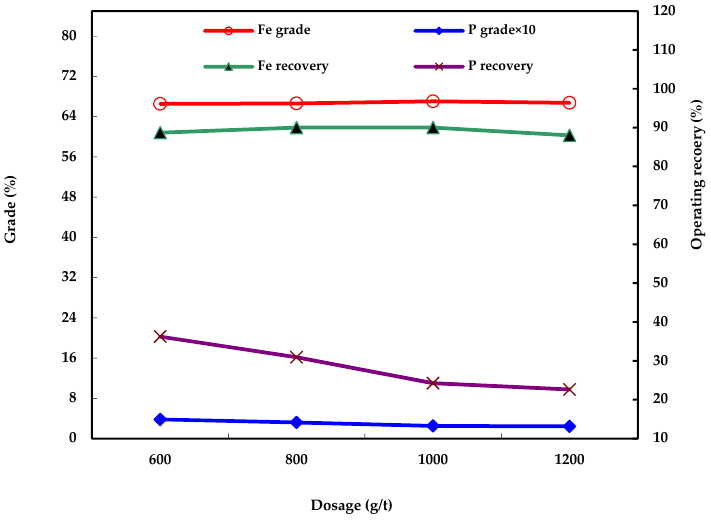
Figure 6. E ff ect of starch dosage on iron and phosphorus grades and recoveries in reverse Figure 6. Effect of starch dosage on iron and phosphorus grades and recoveries in reverse flotation.